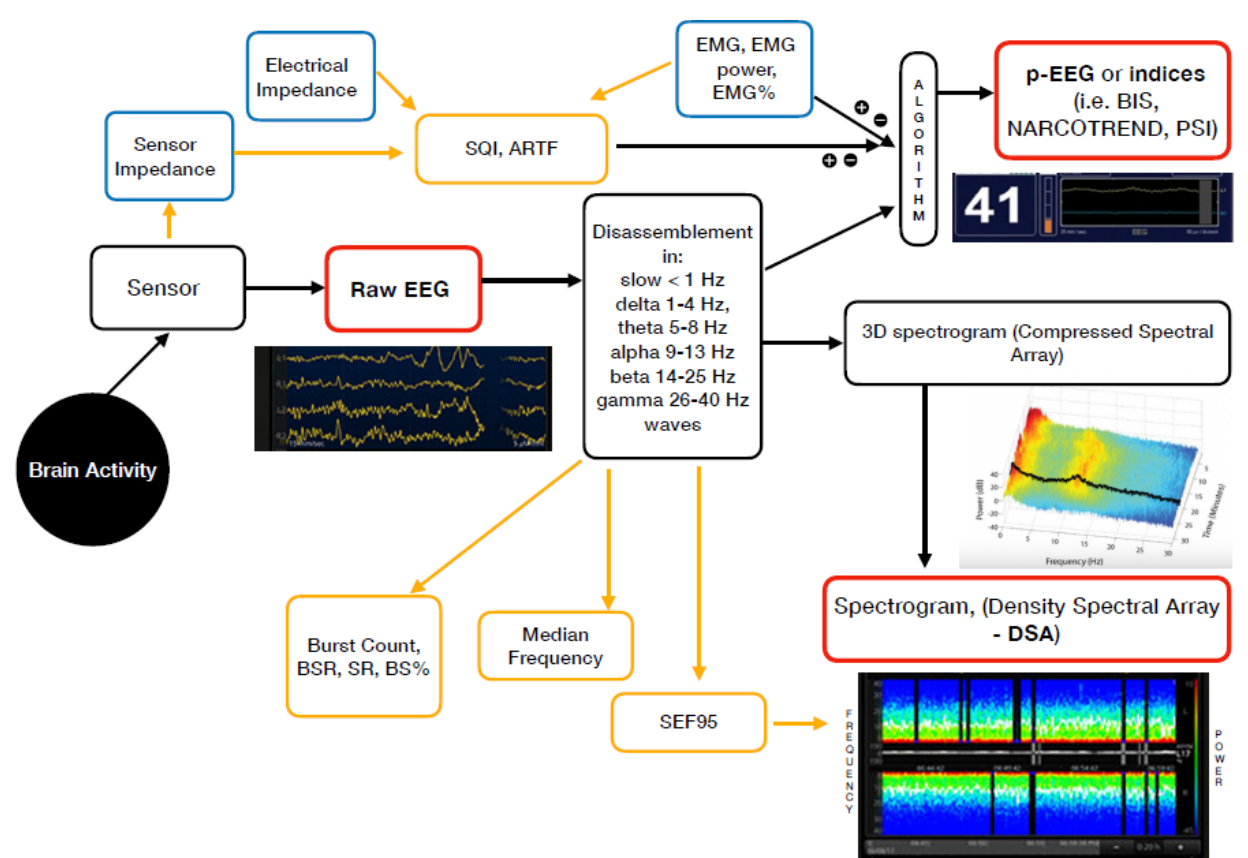
Figure 1. Mechanism of action of the currently available EEG derived anaesthesia monitoring (in red). The sensor is placed on the forehead and records the electrical potentials produced in the cortex resulting in the raw EEG. The majority of the EEG-derived monitors work by disassembling a complex EEG waveform (the raw EEG), into many series of waves of different frequencies (Hertz—Hz). These, together with several of the EEG variables, are converted into a single index through mathematical algorithms by the processed EEG (p-EEG) devices. The obtained index represents the level of hypnosis. However, the index can also be affected by the Electromyography (EMG) and the Signal Quality Index (SQI or ARTF). The spectrogram, is a real time monitoring which portrays all the EEG frequencies and their power over the time in a three-dimensional method (3D spectrogram or Compressed Spectral Array). The latter is then integrated in a two-dimensional plot using colours to represent different powers in the Density Spectral Array (DSA). Derived additional parameters are the Spectral Edge Frequency (SEF95), Median Frequency and the Burst Count (burst/minute) Suppression Rate (SR), Burst Suppression Ratio (BSR), Suppression Ratio (SR) or BS% Indicator (Burst suppression percentage). These can be either represented on the display by a number or visualized on the Spectrogram.